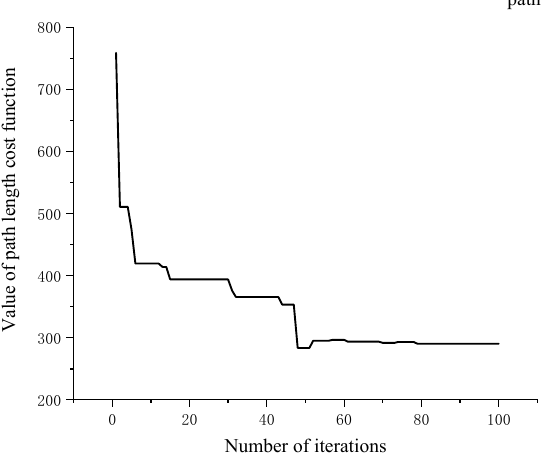
Figure 33. The value of cost function of the radius of gyration of the EPA-PSO algorithm after 100 iterations.